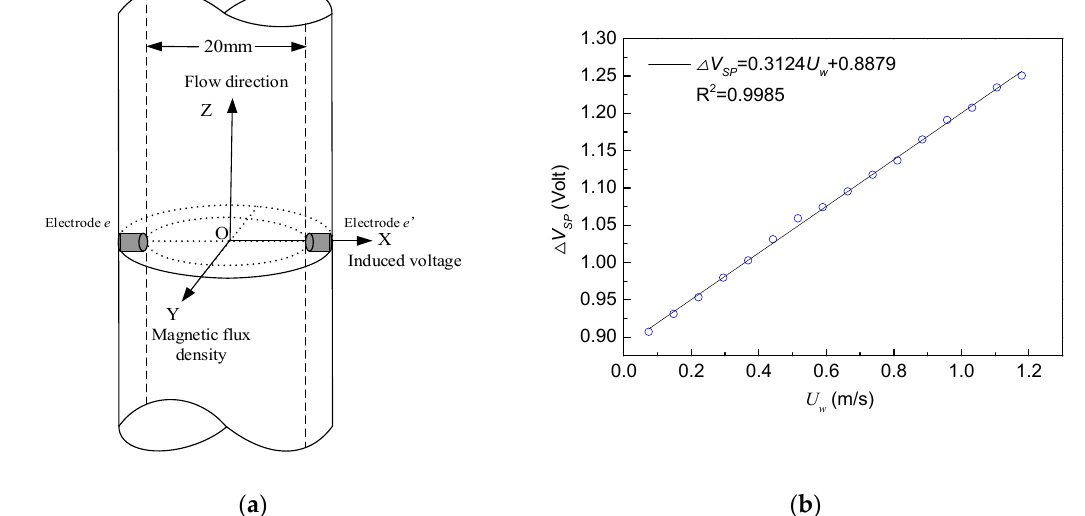
Figure 2. Measuring principle of the EMF. ( a ) Structure of the EMF; ( b ) calibration curve of the EMF in a water single-phase flow.